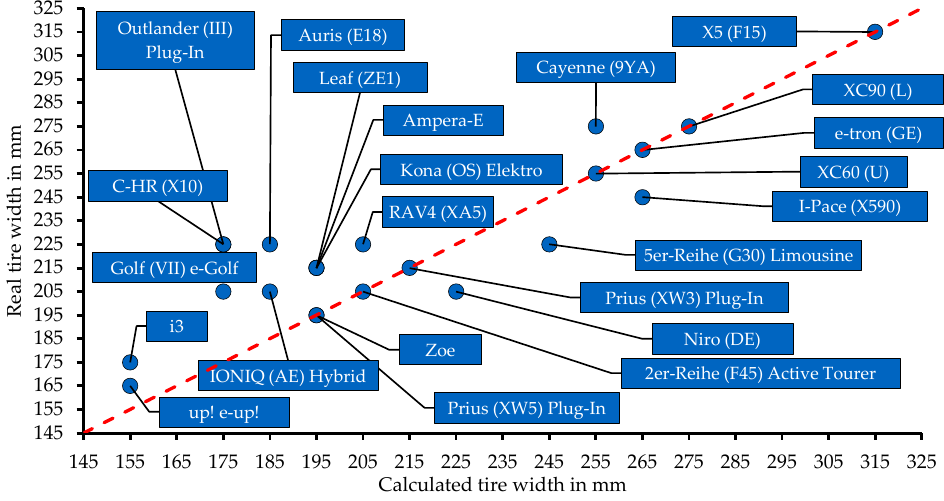
Figure 5. Whole-model plot for the tire-width evaluation.